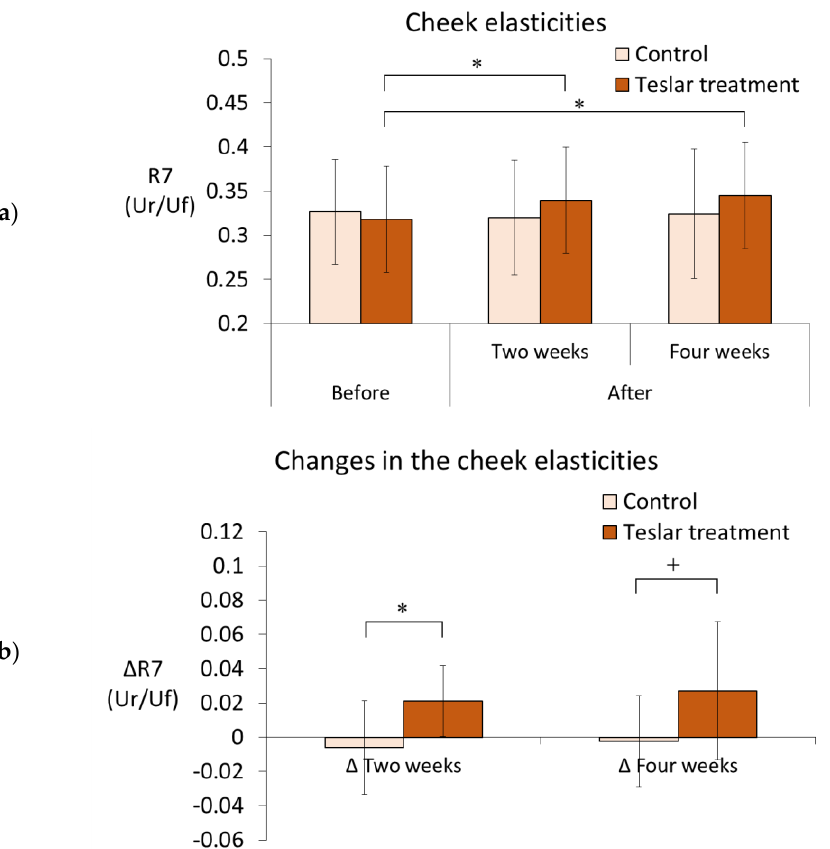
Figure 1. Cheek elasticities and changes in the cheek elasticities—Controls vs. Teslar treatments. ( a ) Cheek elasticities (R7) and ( b ) changes in the cheek elasticities (ΔR7). The results are expressed as the mean ± standard deviation of twelve experiments. * p < 0.05, + p < 0.1.